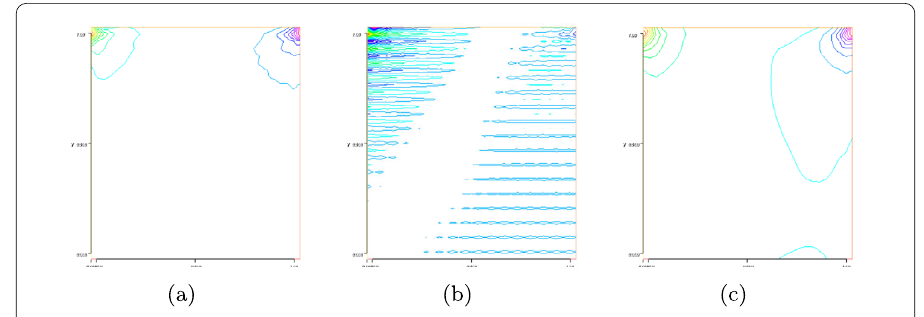
Figure 2 The pressure lines for the Oseen viscoelastic cavity flow. ( a ) Standard FE p 1 b – p 1 – p 1 dg triples; ( b ) FE p 1 – p 1 – p 1 dg triples without stabilization term; ( c ) FE p 1 – p 1 – p 1 dg triples with stabilization term